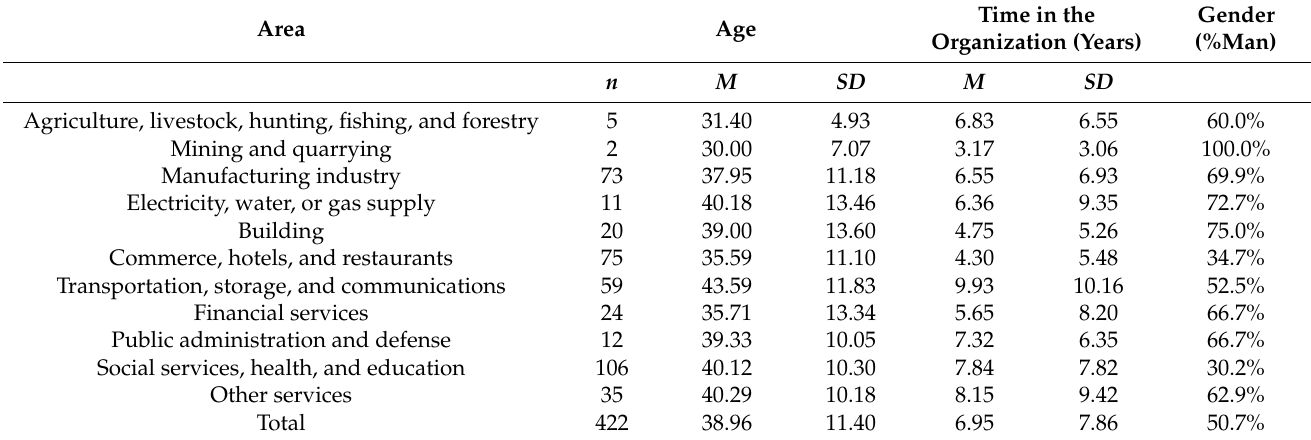
Table 1. Descriptive statistics according to economic